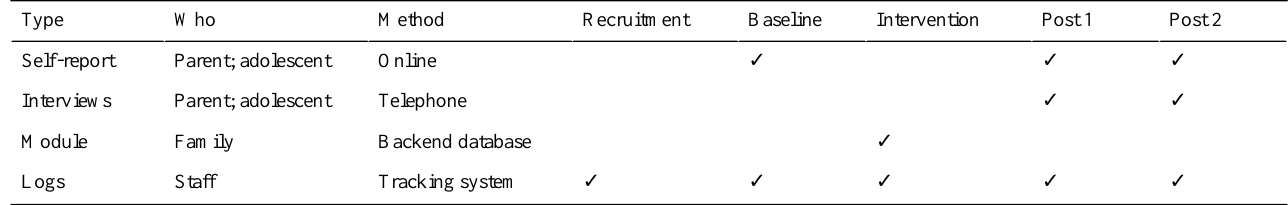
Table 2. Data sources.